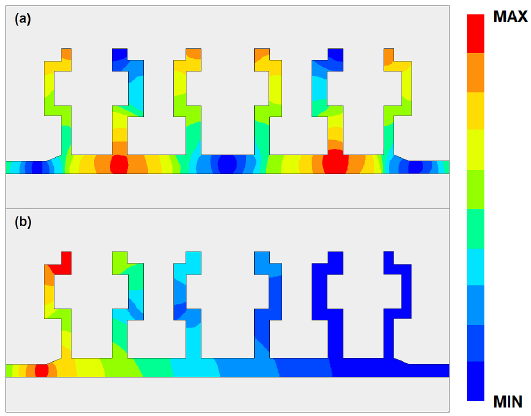
Figure 10. The simulated S -parameters of the SSPP structure with serpentine lines in comparison with the straight-line structure.